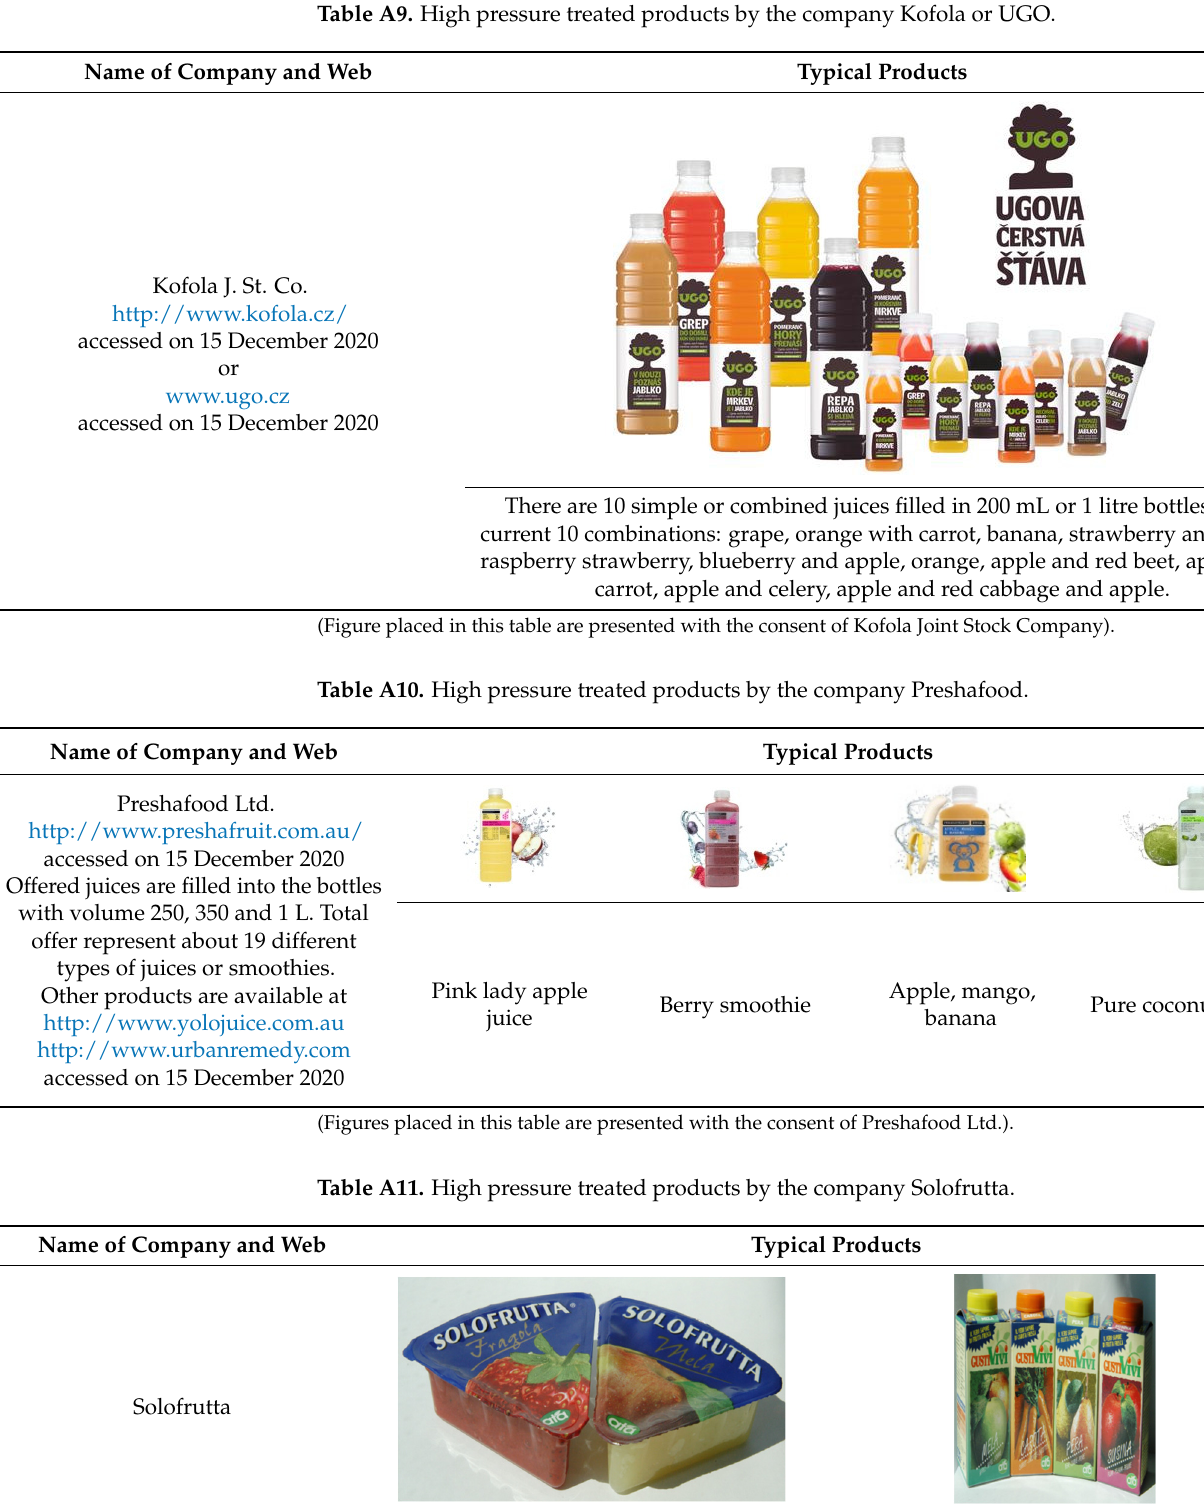
Table A8. High pressure treated products by the company Hoogesteger BV.